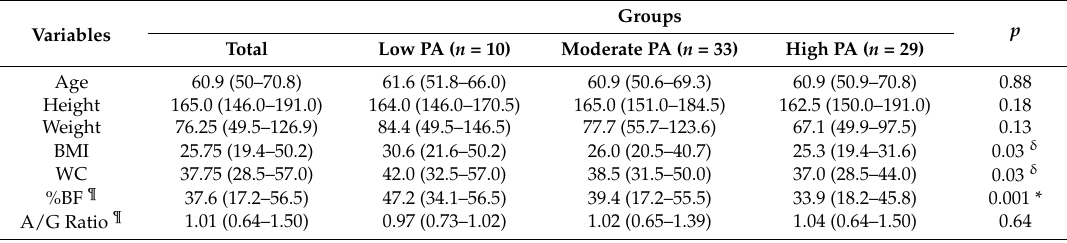
Table 1. Physical characteristics based on physical activity (PA)